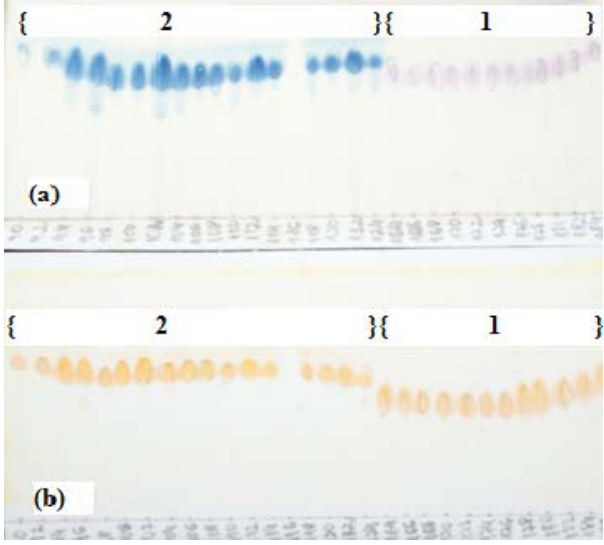
Figure 3. TLC monitoring of fractions from the HSCCC separation of fraction 12 from silica gel chromatography of the MeOH extract of T. catharinensis roots: voachalotine ( 1 ) (fractions 90-124) and 12-methoxy- N -methylvoachalotine ( 2 ) (fractions 164-186). TLC b silica gel plates were eluted in CH Cl -MeOH (9:1 ( v/v )) and the chemical detection was 2 2 done by spraying sulfuric vanillin ( a ) and Dragendorff reagents ( b